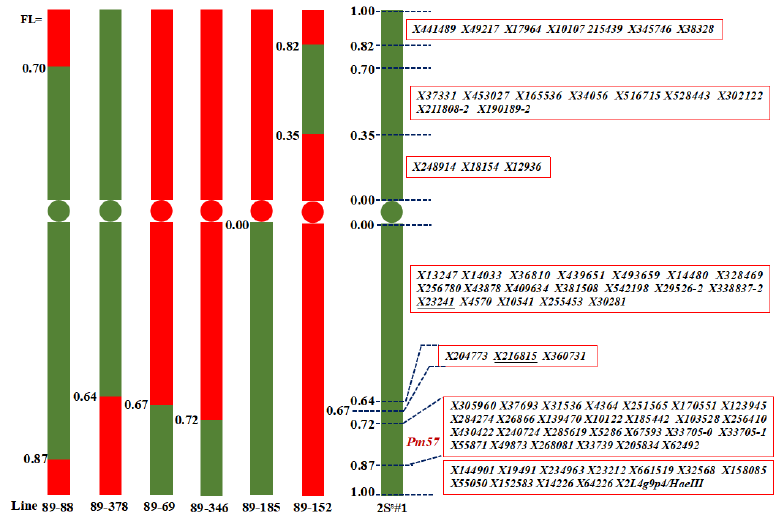
Figure 2. Physical mapping of Ae . searsii chromosome 2S s #1 specific molecular markers to different fraction length intervals. Numbers on the left of each chromosome represent the fraction length (FL) of recombination. Lines 89-88, 89-69, 89–346, and 89–185 carried Pm57 , which mapped the gene at LFL0.72–0.87; Marker names located at each interval are in the red boxes on the right of chromosome 2S s #1; Chromatin of Ae . searsii is displayed in green color and wheat in red color. No specific markers were found at SFL0.70–0.82 and LFL0.67–0.72 of 2S s #1. Markers X23241 and X216815 underlined are used for subsequent selection of putative recombinants in the F 2 segregating population.